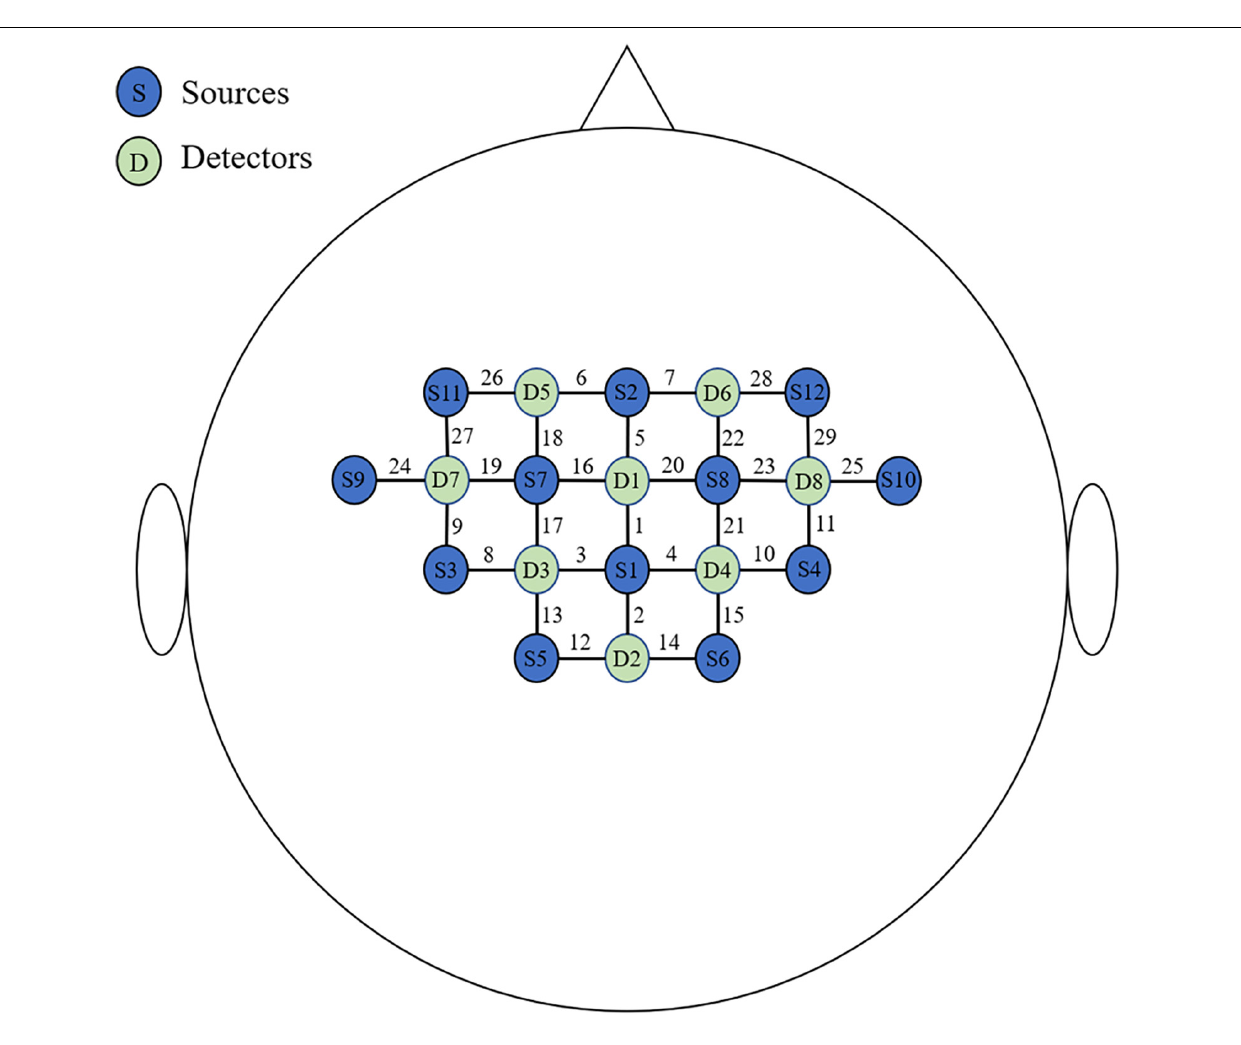
FIGURE 1 | The montage of the